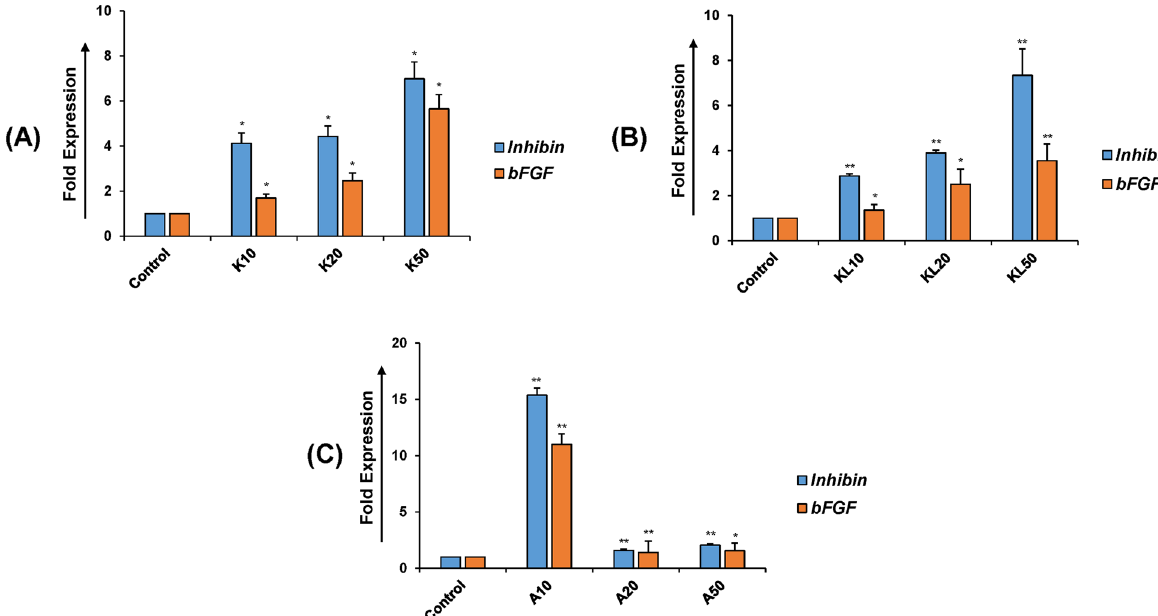
Fig. 3 Treatment with KGF and KITLG enhances the growth of granulosa cells. The mRNA expressions in cultured granulosa cells in response to KGF and KITLG treatment were determined using Real-time PCR. Inhibin-α was consistently increased with doses dependent manner of KFG ( A ) and KITLG ( B ). The mRNA expression of bFGF remained almost unchanged at 10 and 20 ng/ml as compared to the control with both KGF ( A ) and KITLG ( B ) treatment and significantly upregulated at 50 ng/ml concentration. Upregulation for Inhibin - α and bFGF expression was more consistent and significant at the dose of 50 ng/ml as compared to that of 10 and 20 ng/ml. C Combined treatment of KGF and KITLG at 10 ng/ml resulted in increased expression of Inhibin - α and bFGF (> 10-fold), whereas there is no change at the dosage of 10 and 20 ng/ml. These observations suggest the role of KGF and KITLG in growth of granulosa cell. K represents the KGF, KITLG is denoted by KL and A is KGF are defined as 10, 20, and 50 ng/ml for both KGF and KITLG. Values are expressed as the mean